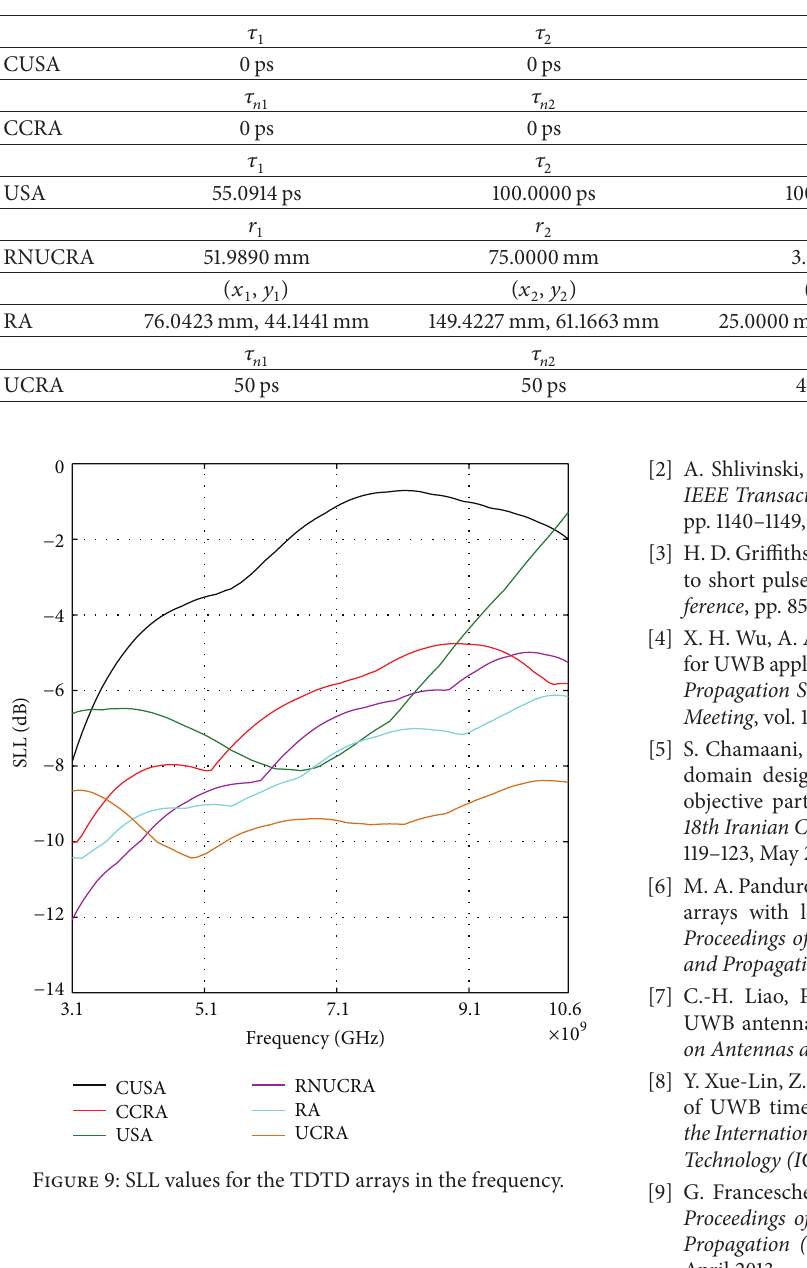
Table 2: Design variables for the TDTD array geometries.